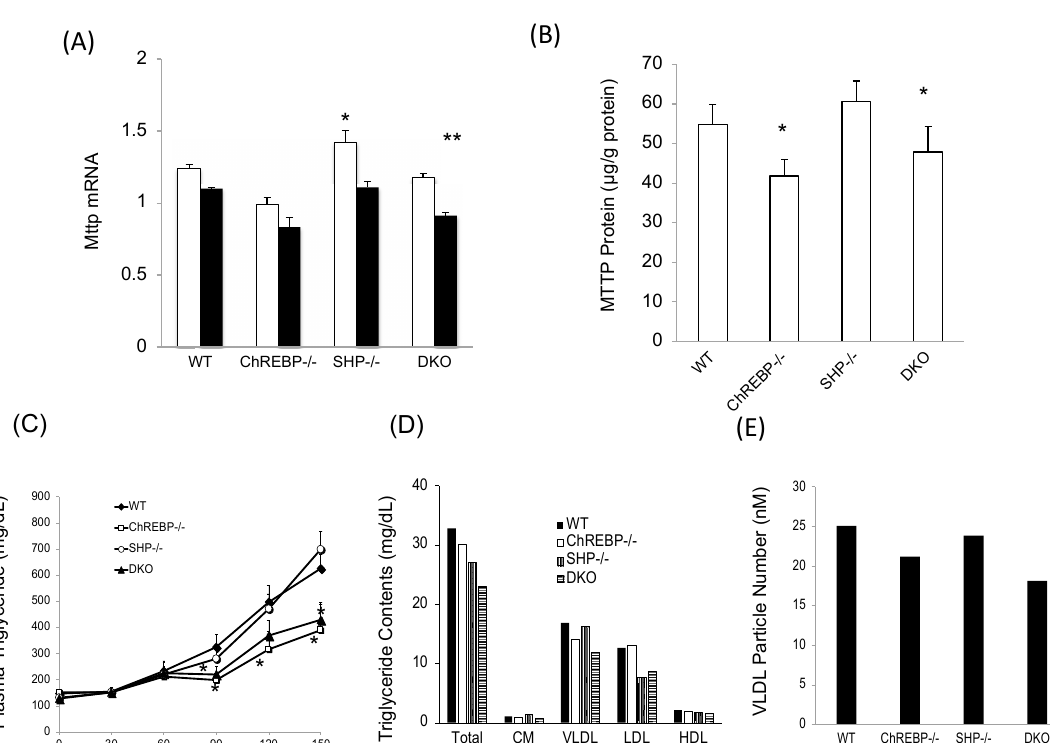
Figure 3. Shp deletion failed to recover decreased Mttp expression, and thereby, VLDL secretion rates mediated by Chrebp deletion. ( A ) Hepatic Mttp mRNA levels in the livers of wild-type (WT), Chrebp − / − , Shp − / − , and DKO mice. Mttp mRNA levels were detected by real-time PCR. Pol2 expression was used as an internal control. * p < 0.05 vs. WT (fast), n = 4. ** p < 0.05 vs. WT (fed), n = 4. Data are represented as means ± SD; ( B ) Hepatic MTTP protein expression in the livers of WT, Chrebp − / − , Shp − / − , and DKO mice. MTTP protein levels were measured by ELISA and corrected for total protein levels. * p < 0.05 vs. WT, n = 5–7. Data are represented as means ± SD; ( C )